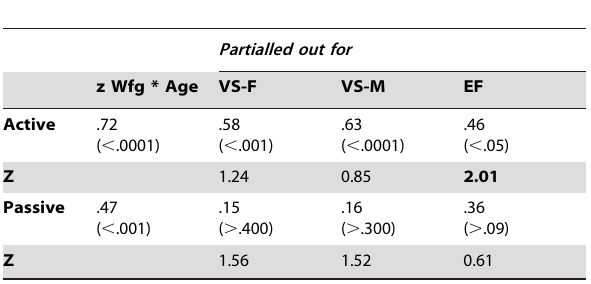
YOUNGER GROUP OLDER GROUP